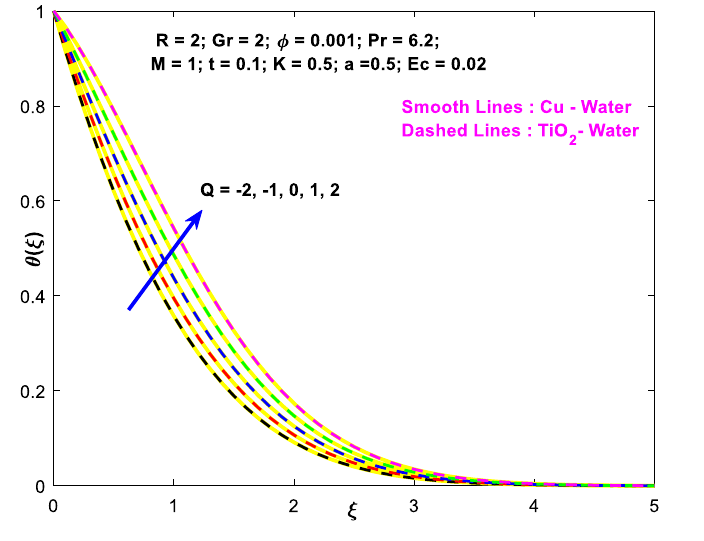
Figure 13. Q v/s θ .